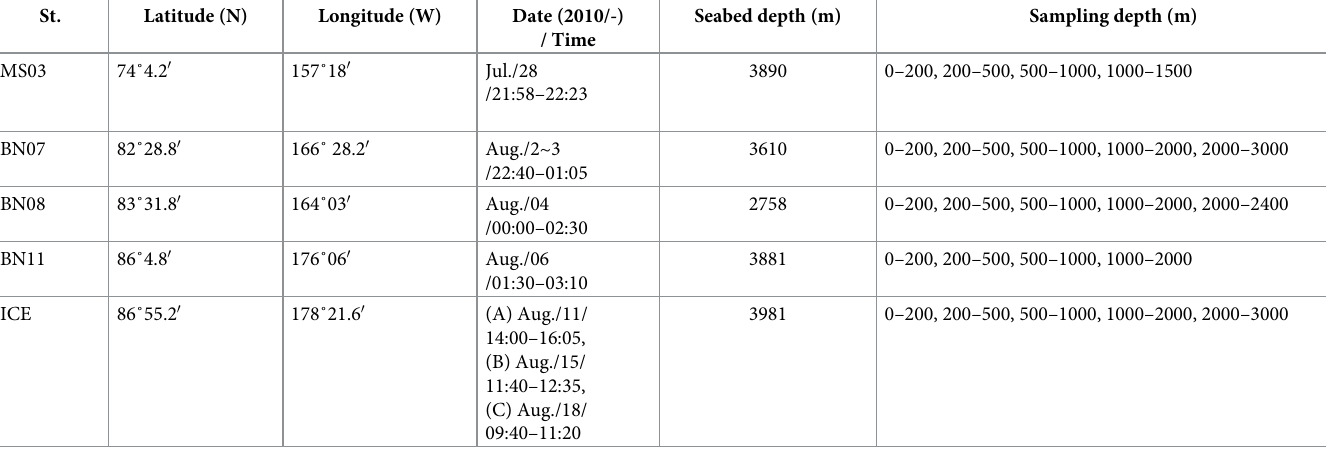
Table 1. Geographical coordinates of sampling stations with date, time, and depth of sampling at each station during the polar cruise.